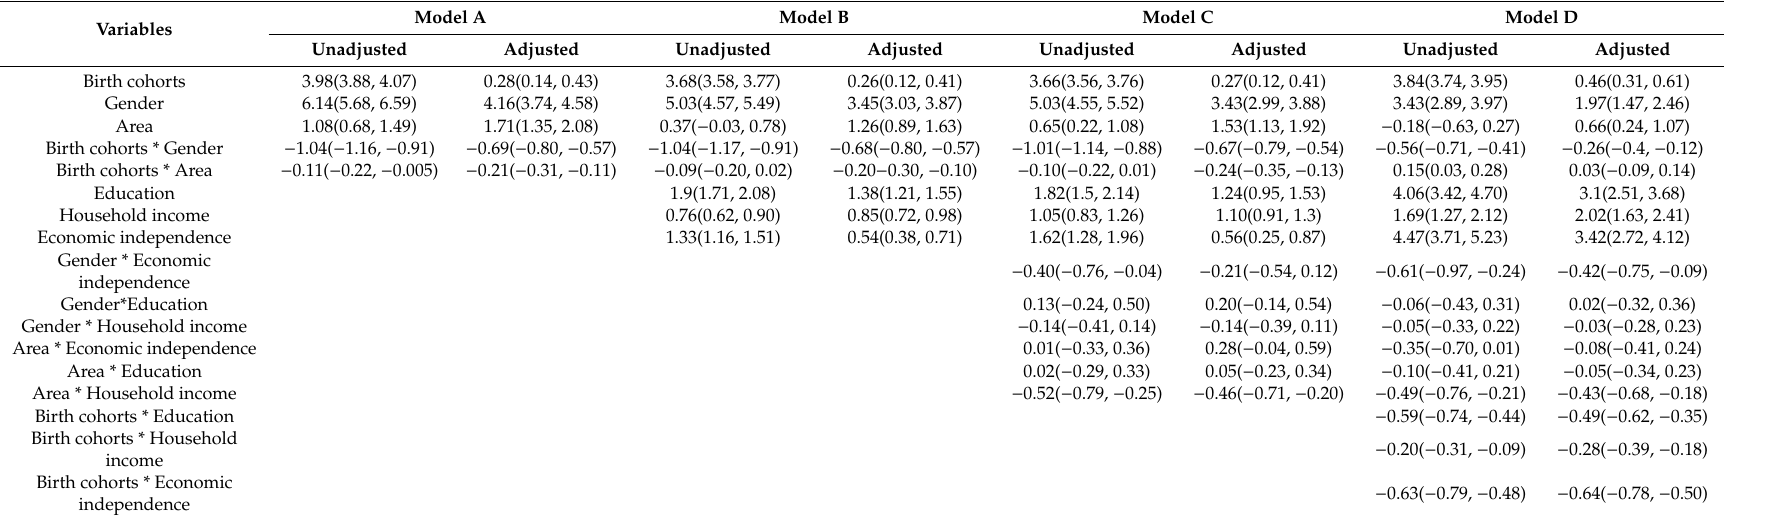
Table 5. Coe ffi cients (95% confidence intervals) from the linear mixed-e ff ects models predicting cognitive functions